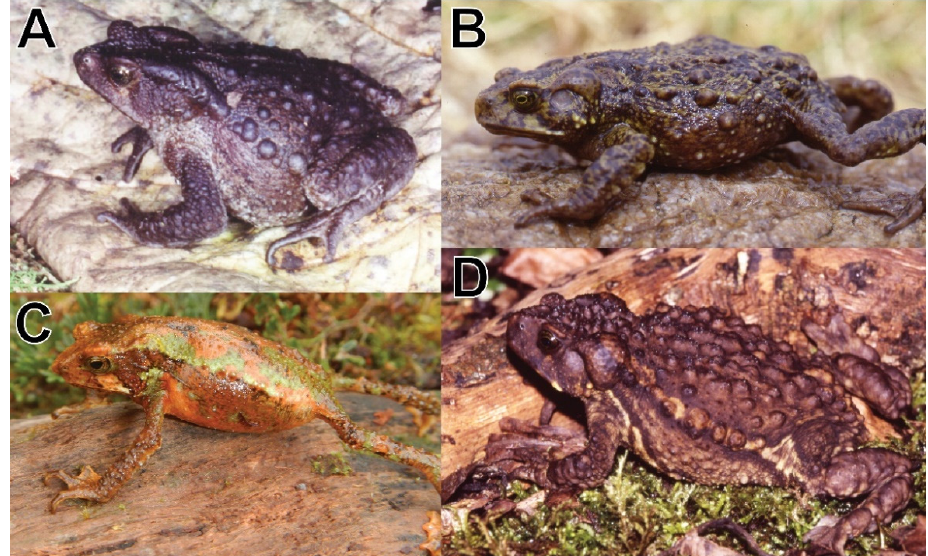
Figure 3. Life specimens in dorsolateral views of ( A ) Rhinella moralesi sp. nov. (holotype, MUSM 15959, SVL 67.6 mm, male), ( B ) R. chavin (MUSM 20027, SVL 64.9, female) ( C ) R. yanachaga (MUSM 31100, juvenile), and ( D ) R. multiverrucosa (MTD 44749, SVL 68.9 mm, female). Photos by A. Catenazzi, ( A ) E. Lehr ( B , C ), and M. Lundberg ( D ).